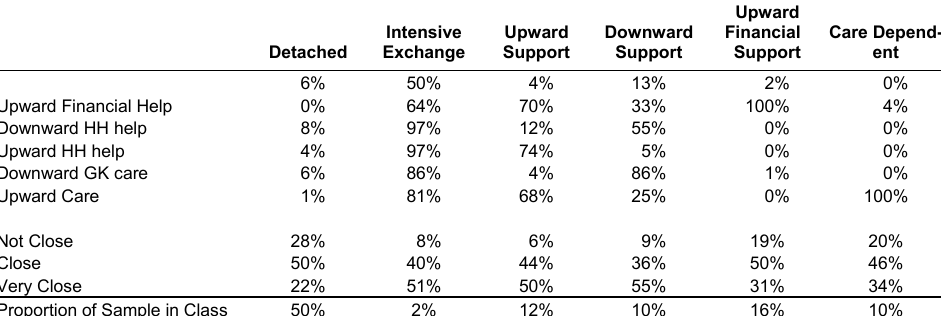
Results of Latent Class